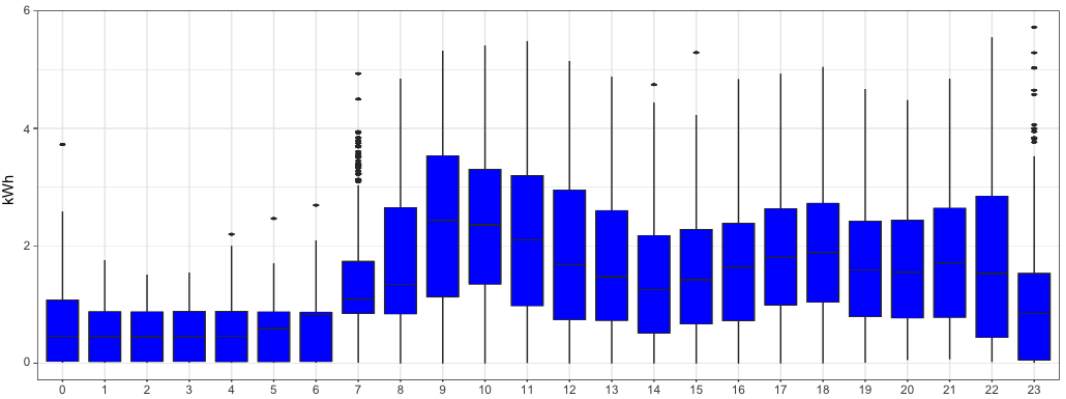
Figure 4. Daily consumption per hour for smart-meter 18 along